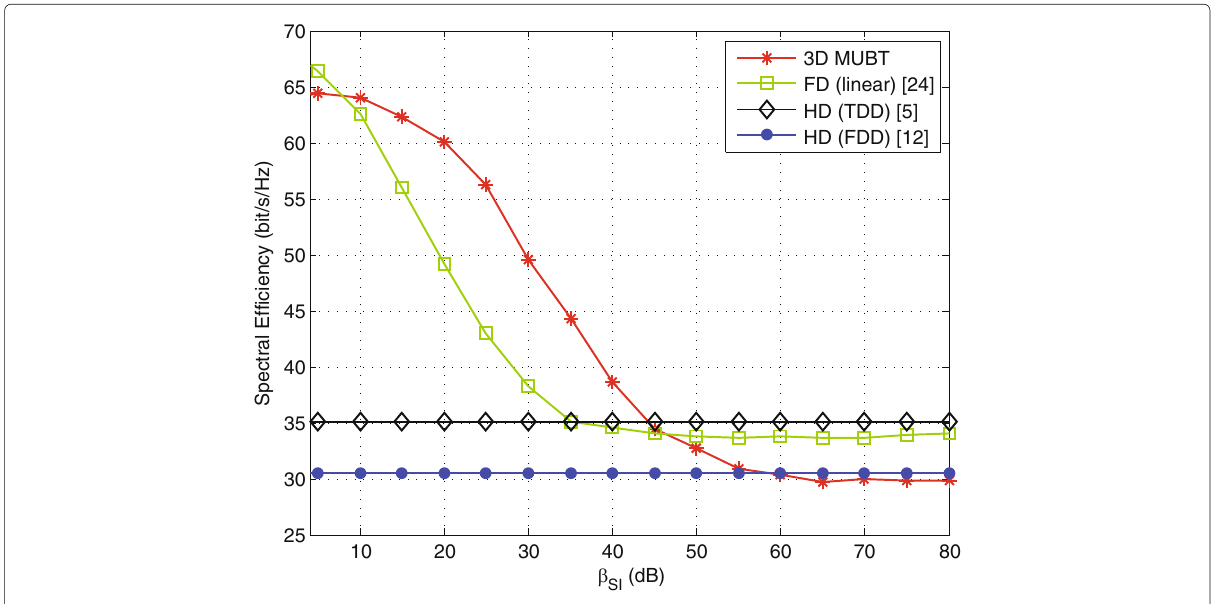
Fig. 7 SEs versus β SI in different scenarios with average receive SNR =